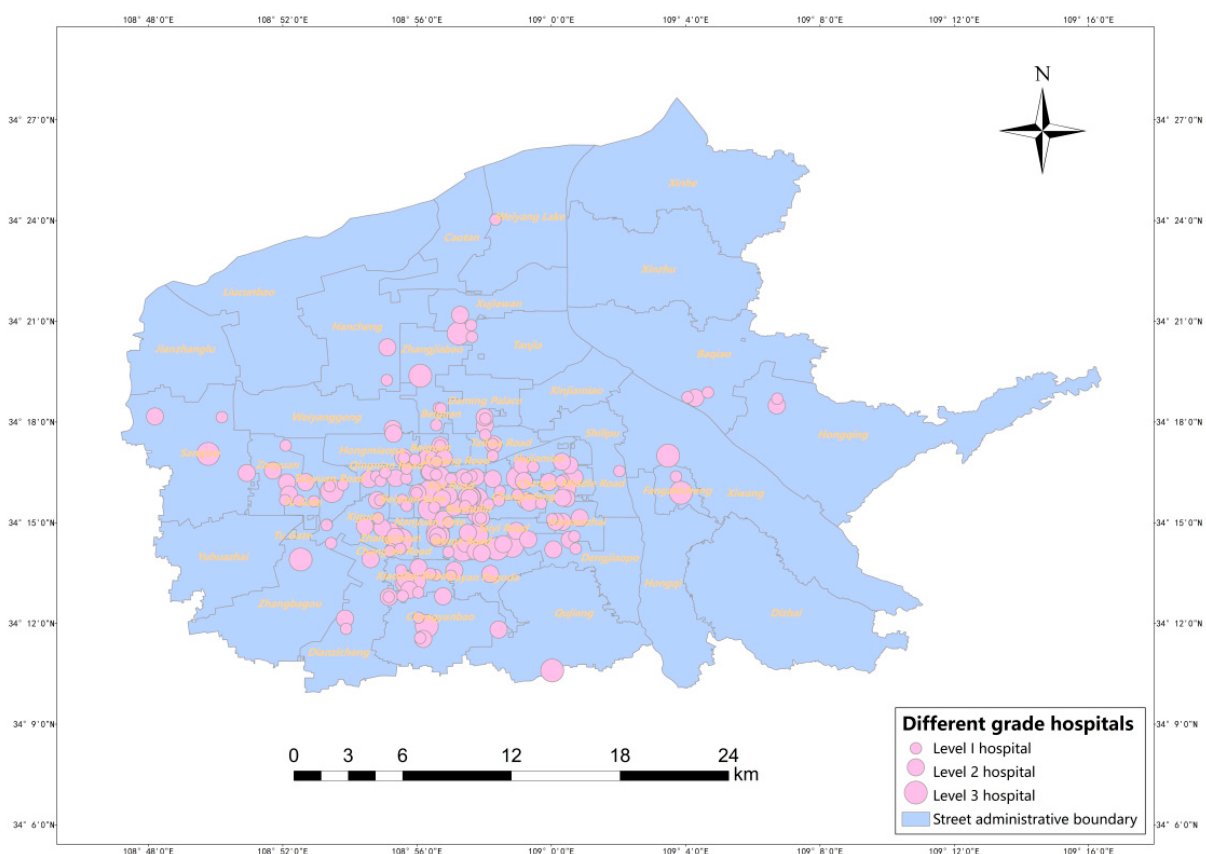
Figure 2. Distribution of different-grade medical facilities.